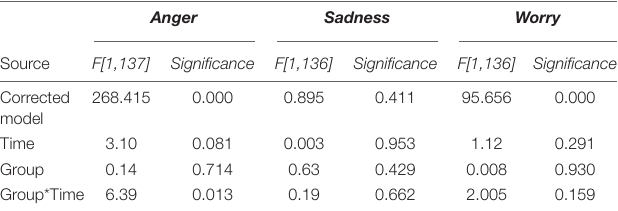
TABLE 4 | GLMM results for anger, sadness, and worry coping.